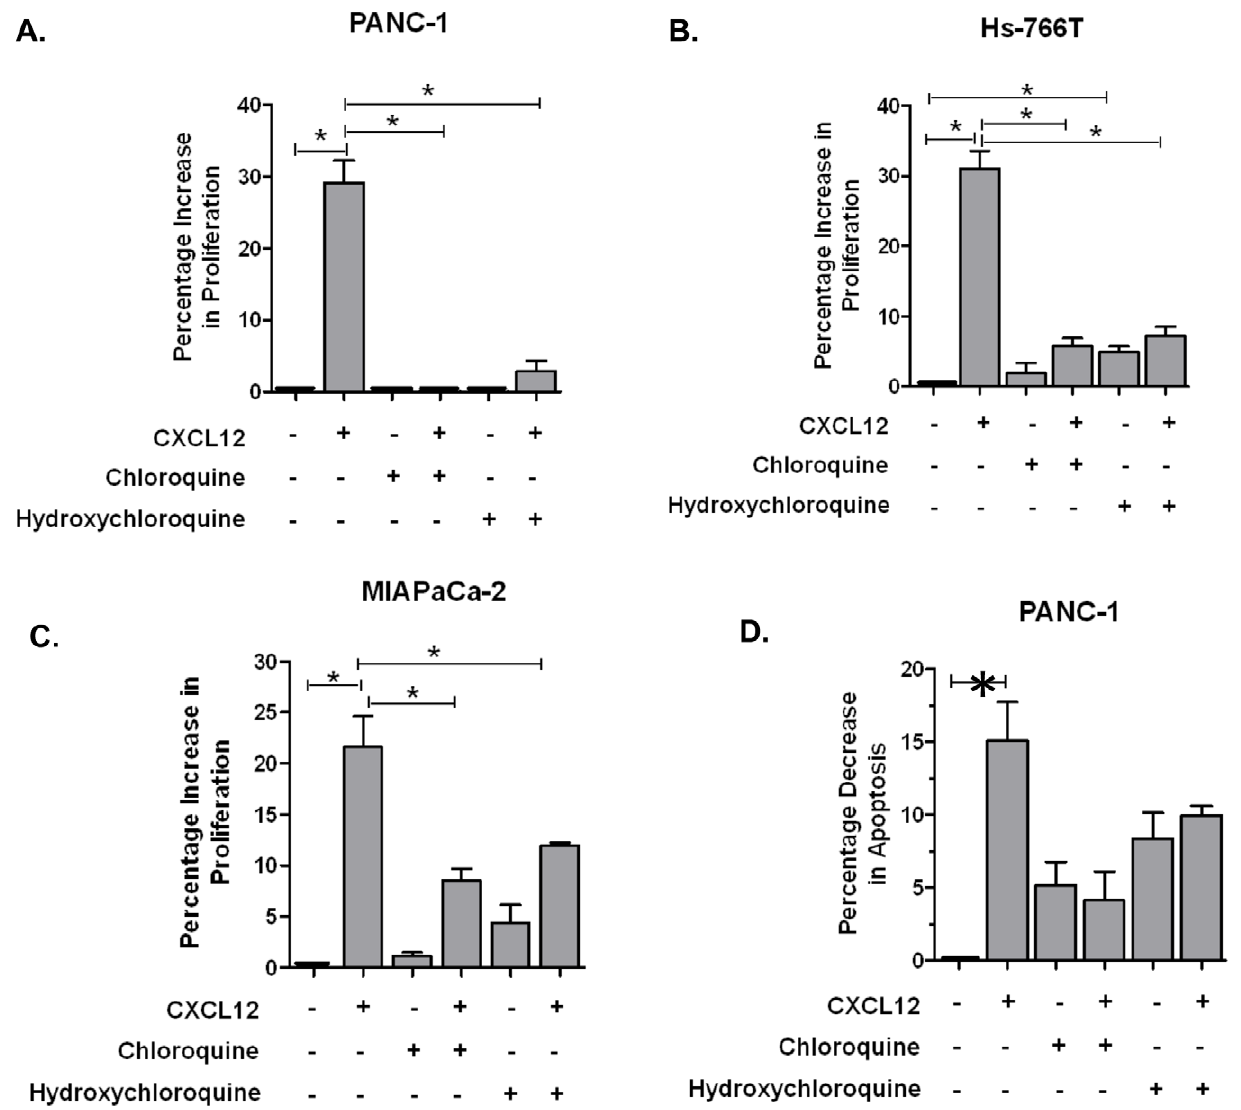
Figure 7. Chloroquine and hydroxychloroquine decrease CXCL12-mediated proliferation in pancreatic cancer cell lines. (A) PANC-1, (B) Hs-766T, and (C) MIAPaCa-2 cells were pretreated with chloroquine or hydroxychloroquine (0.1 m M) for 30 minutes after which cells were exposed to CXCL12 (200 ng/ml) for 72 hours. (D) Pretreatment with chloroquine and hydroxychloroquine also triggered apoptosis and decreased CXCL12- mediated apoptosis in PANC-1 cells. The data show the mean of triplicate experiments. P -values , 0.05 were considered statistically